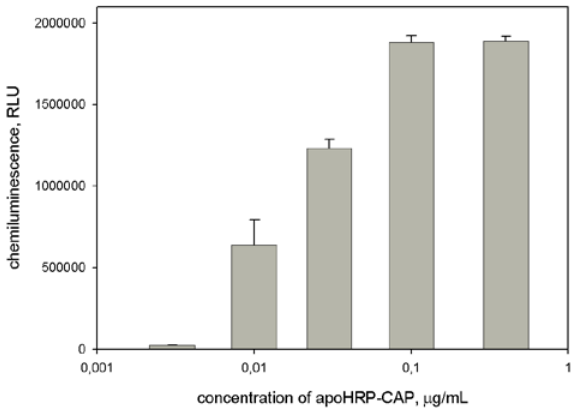
Figure 5. Dependence of light output on concentration of apoHRP-CAP (5:1) at use of biotinylated REP/Stp-HRP as a signaling system. Experimental conditions: concentrations of HBV DNA biotin-REP were 50 pM and 10 pM, respectively; Stp-HRP dilution = 1:500. Chemiluminescence was measured 8 min after the initiation of luminol oxidation. Each measurement was repeated thrice.